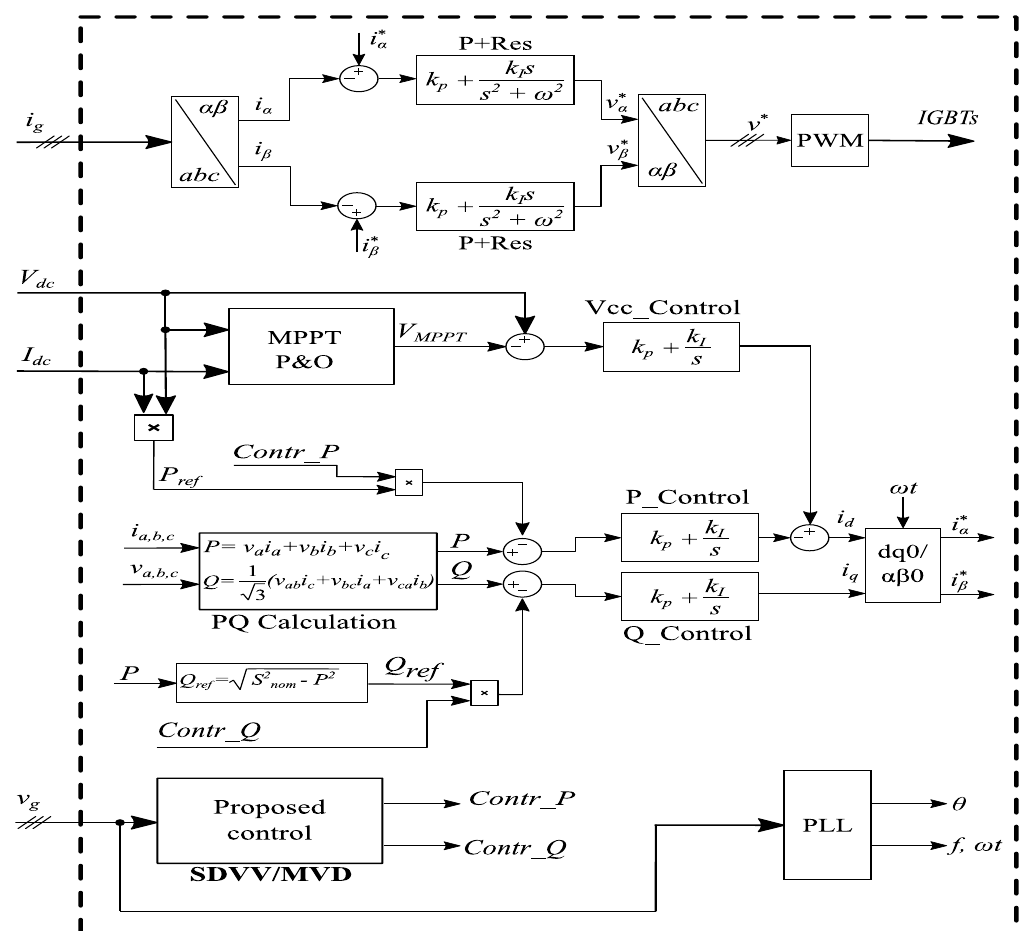
Figure 3. Block diagram of the inverter with proposed control, based on the αβ stationary system.